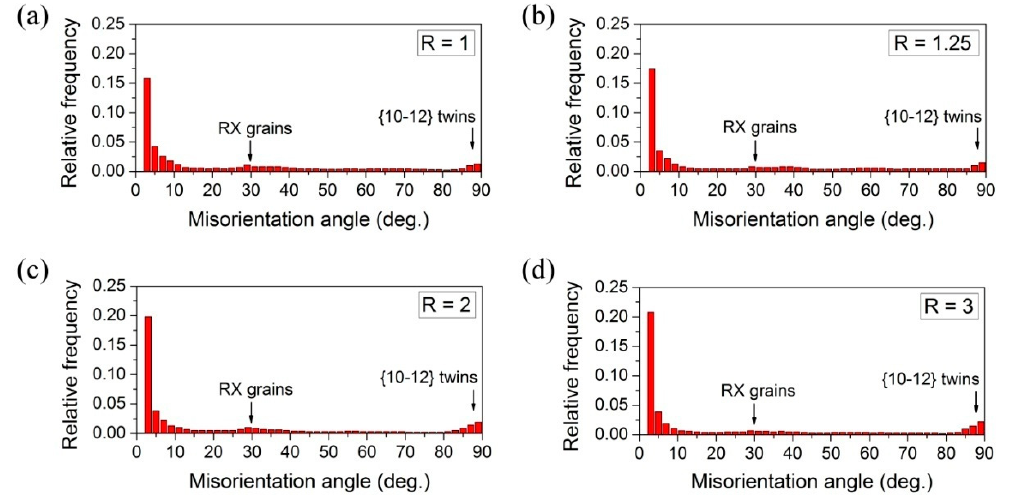
Figure 1. Electron backscattered diffraction (EBSD) inverse pole figure (IPF) maps of the as-rolled Mg-6Sn sheets processed at speed ratio of ( a ) R = 1, ( b ) R = 1.25, ( c ) R = 2 and ( d ) R = 3 with ( e ) grain size distributions.